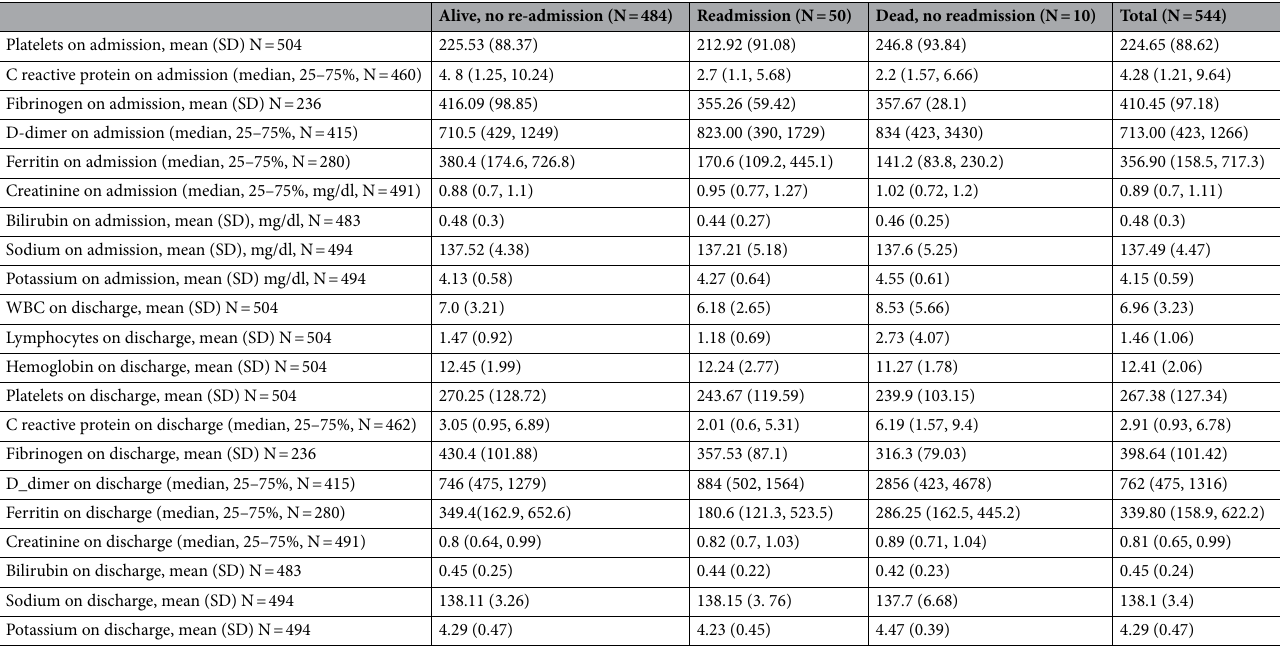
Table 1. Patients’ characteristics.